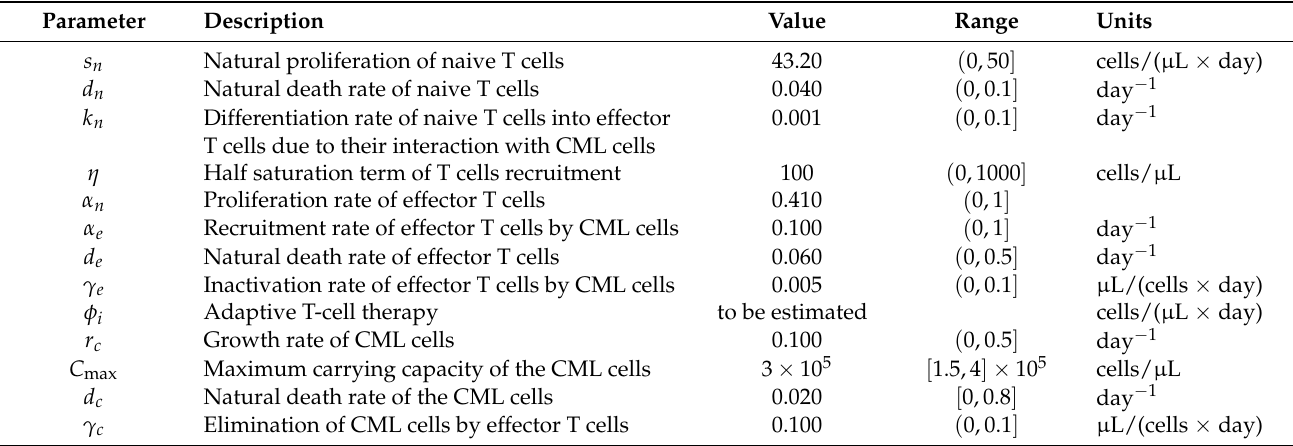
Table 1. Parameter information for the CML-immunotherapy dynamical